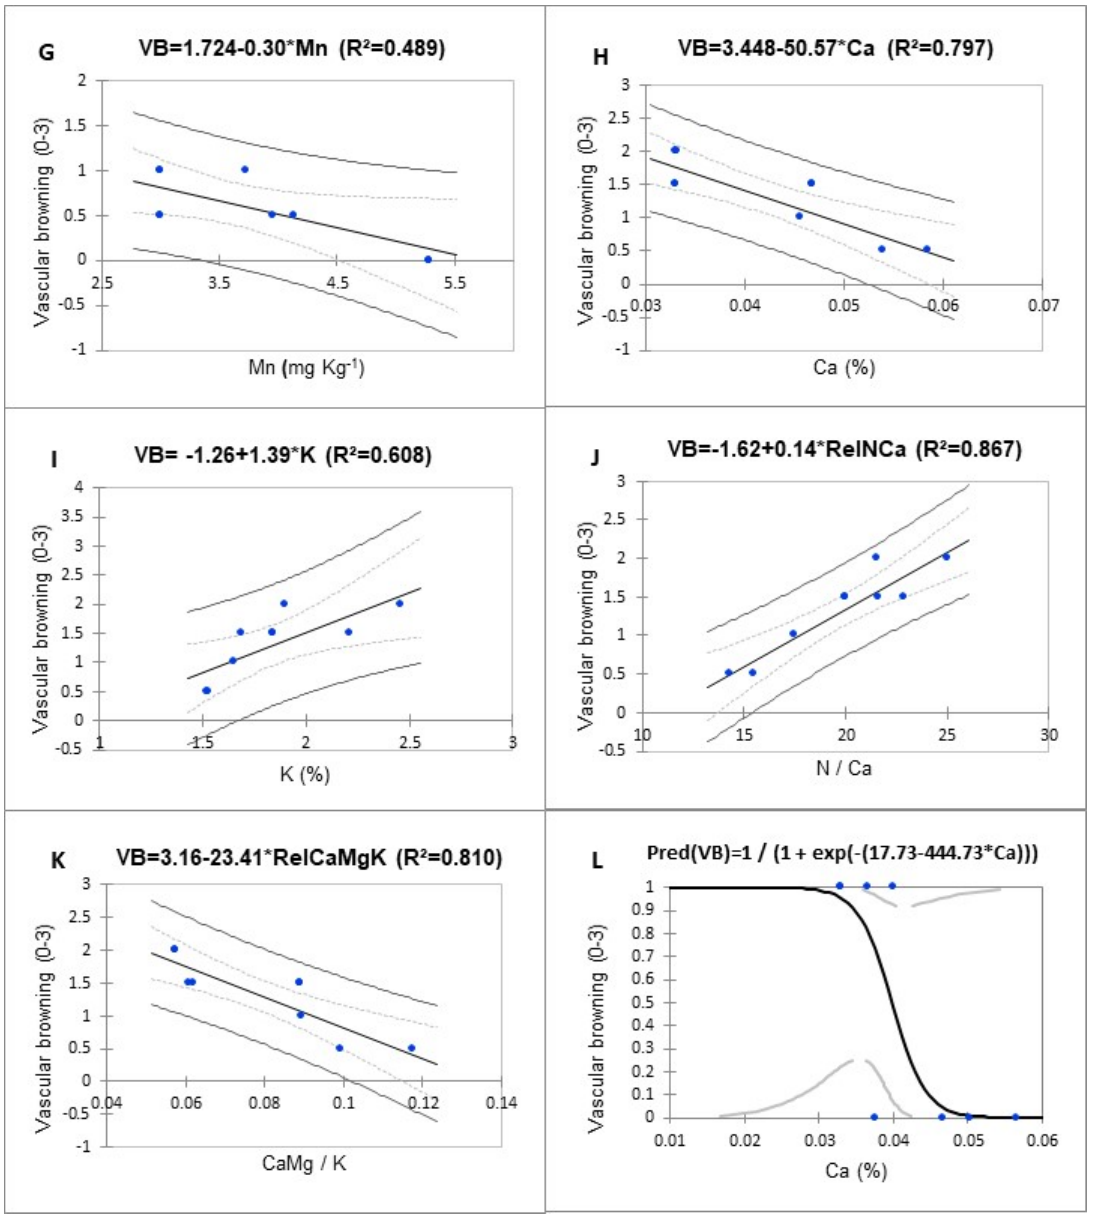
Figure 8. Minerals content (Mn, N/Ca, B, Ca, K, and CaMg/K) and their relation with vascular browning (VB): ( A,B ) LE farm (DM-22, ST = 3 weeks); ( C – E ) LE farm (DM-26, ST = 5 weeks); ( F , G ) LE farm (DM-30, ST = 4 weeks); ( H – K ) LE farm (DM-30, ST= 5 weeks); ( L ) EB farm Logistic regression (DM-30, ST = 5 weeks).